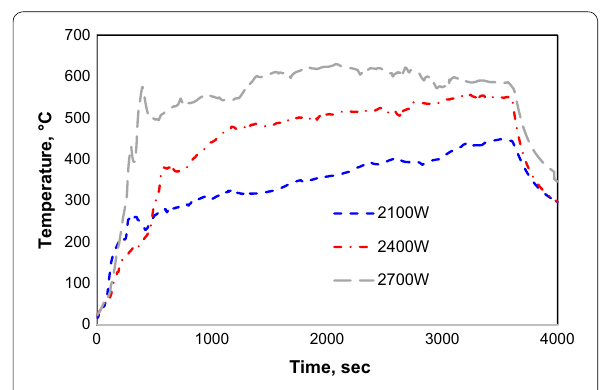
Fig. 3 Hemp pyrolysis temperature profiles